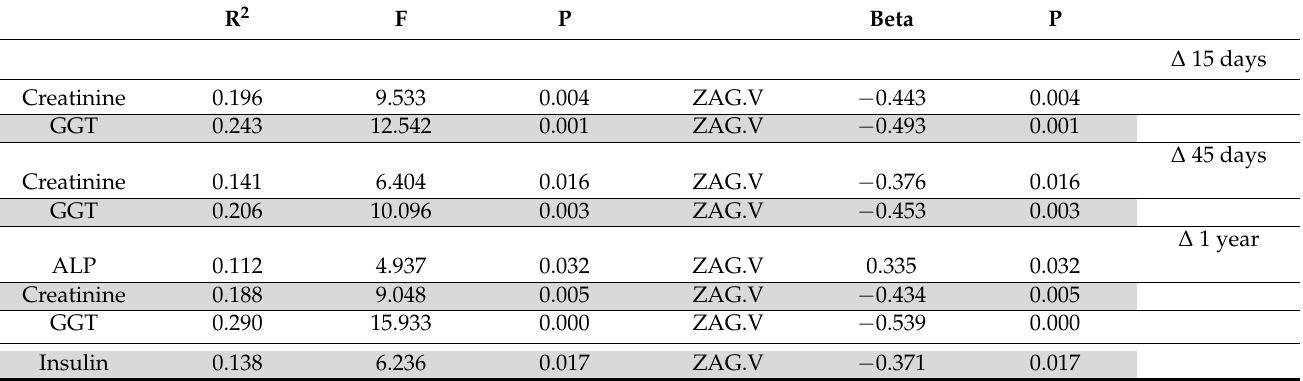
Table 5. Regression analysis predicting clinical and biochemical changes using metabolic syndrome and visceral ZAG (ZAG.V) gene expression levels as independent